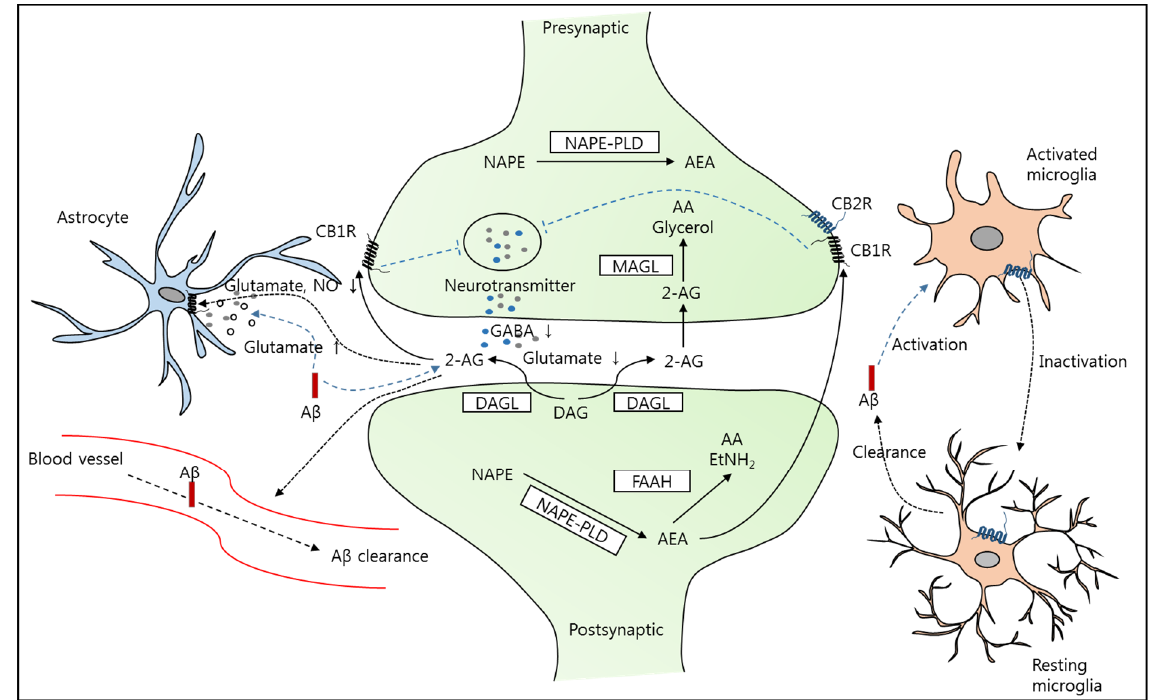
Figure 2. Schematic representation of the modulation of the endocannabinoid system (ECS) involved in AD pathology. In the central nervous system, the main components of the ECS (such as AEA and 2-AG) are diffusely distributed in both the presynaptic and postsynaptic compartments. AEA is synthesized through NAPE–PLD and degraded by the enzyme FAAH, whereas 2-AG is synthesized through DAGL in the postsynaptic terminal and degraded by MAGL. The release of AEA and 2-AG into the synaptic cleft stimulates CB1/CB2 receptors on presynaptic neurons to inhibit the release of neurotransmitters such as glutamate or GABA, leading to synaptic dysfunction. A β enhances 2-AG signaling, leading to the failure of neurotransmission. In addition, A β stimulates both astrocytes and microglia and accelerates neuronal damage through glutamate-mediated excitotoxicity and neuroinflammation. Modulation of the ECS has been suggested to reverse several pathological symptoms of AD. For example, the pharmacological elevation of 2-AG/AEA activates CB1 receptors on astrocytes to reduce the release of glutamate and NO and facilitates A β clearance through blood vessels. Moreover, activation of CB2 receptors on microglia results in the recovery of the anti-inflammatory phenotype of microglia to increase A β clearance. The blue dotted arrows indicate the signaling pathways induced by A β .